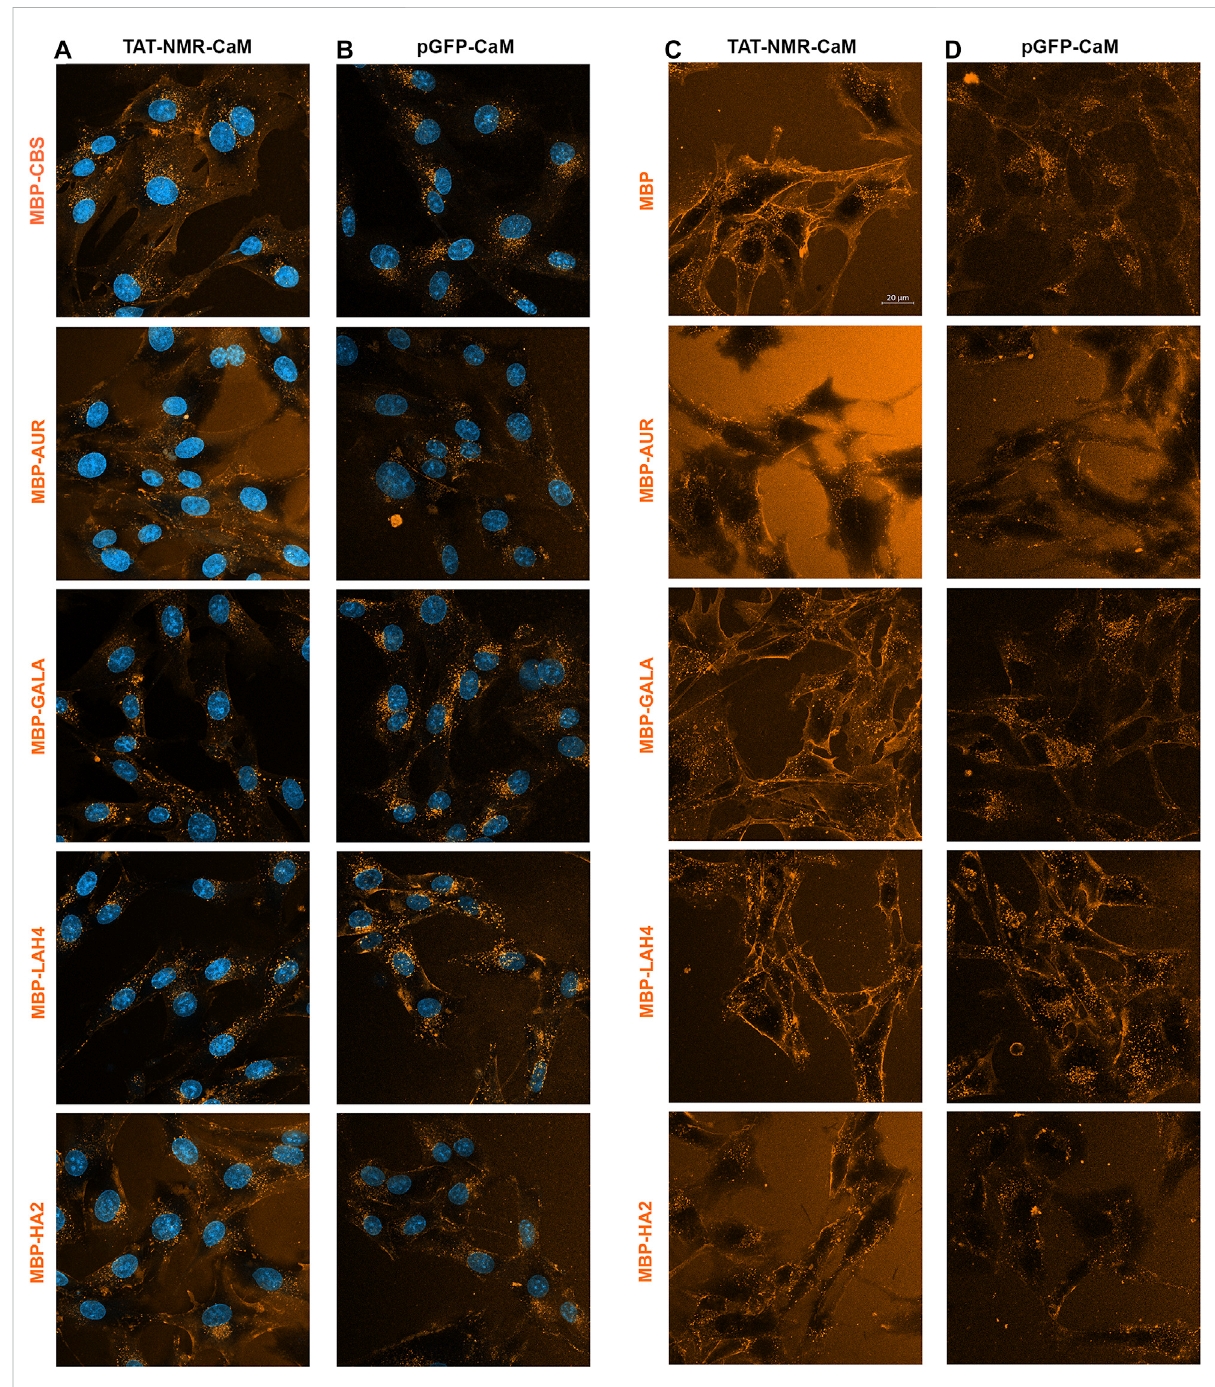
FIGURE 11 Direct Comparison of internalization ef fi ciencies for the MBP-EP-CBS cargos internalized by two next generation adaptors. (A) Internalization of the fi ve 550-labeled MBP-EP-CBS cargos by TAT-NMR-CaM (A) and pGFP-CaM (B) under the same conditions used with TAT-EP-CaM adapters. Internalization of these 5 cargos with (C) TAT-NMR-CaM and (D) pGFP-CaM analyzed in the later part of a 1 h internalization incubation when the complex is present in